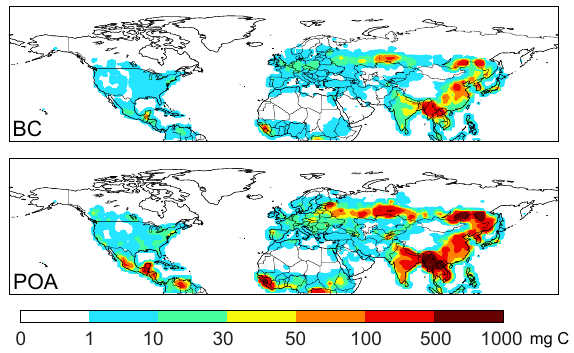
Fig. 1. GEOS-Chem emissions of black carbon (BC) and primary organic aerosol (POA) in April 2008. Annual regional totals are in Table